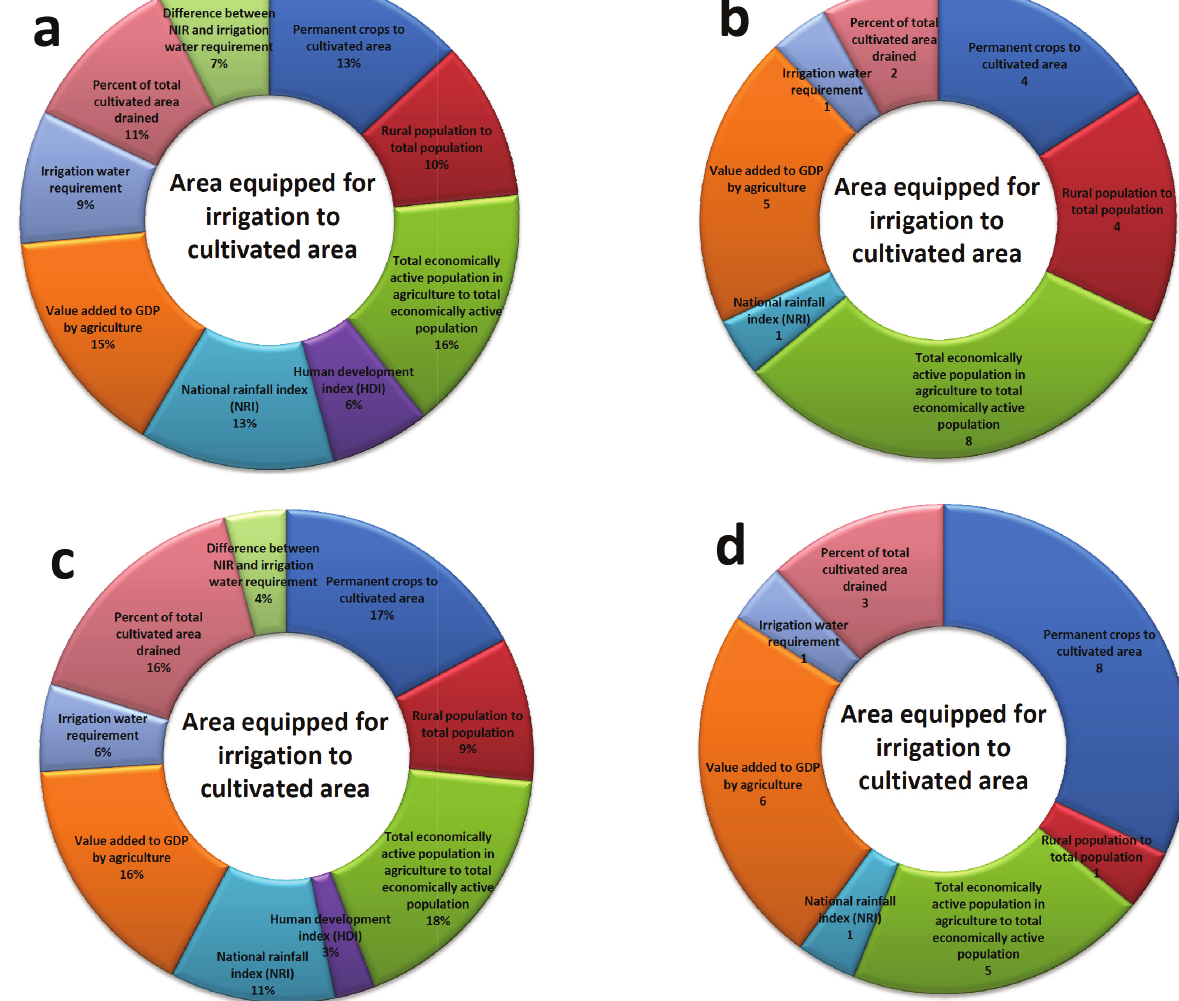
Figure 13: Effect of the main indexes on equipped area (10th index) in Americas (25 countries according to available data); a and c, average of coefficients for each index in the Table 1 and Table 2 respectively, b and d, number of cases that each index has been introduced as main factor to estimate 10th index (maximum coefficient in each formula) based on Eqs. 8 and 9